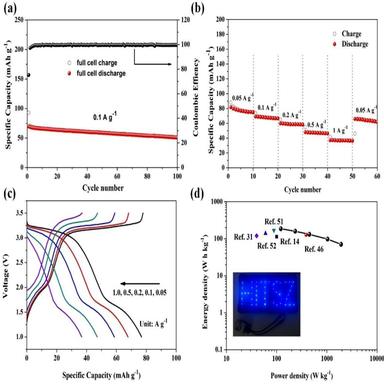
(a) Cycling performance of NC/MoSe2@NC//Na3V2(PO4)3/C full cell at 0.1 A g−1 (b) rate capabilities (c) charge/discharge curves at various rates (d) Ragone-like plot of the full SIBs cell.